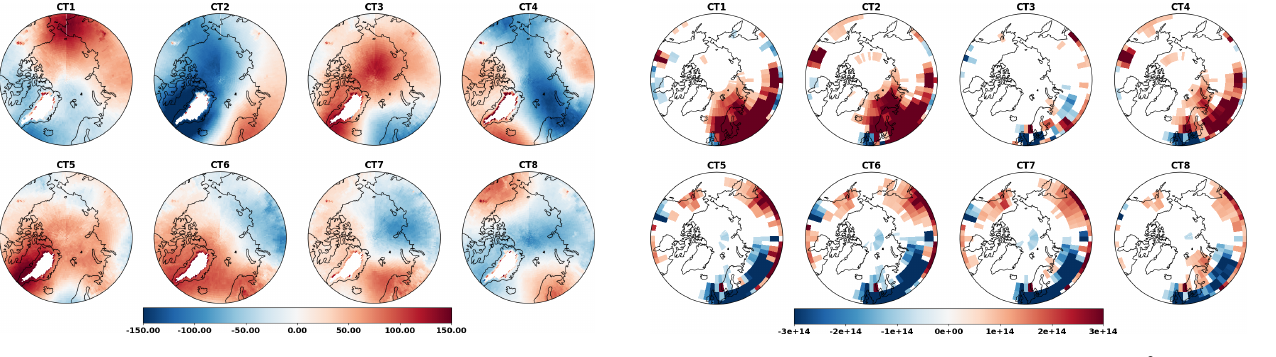
Figure 5. NO 2 total column anomalies (moleculescm − 2 ) based on OMI data for the eight circulation types. Only those anomalies that are statistically significant at the 90% confidence level are shown.